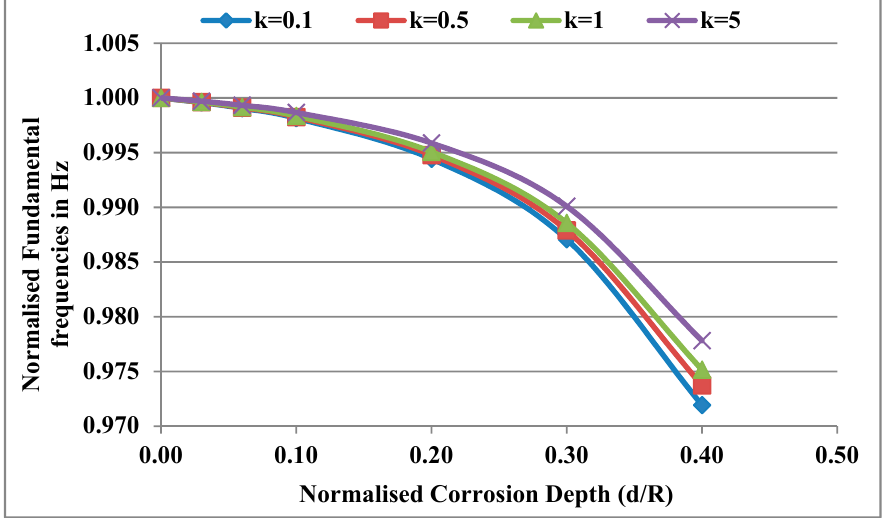
Figure 8. Effect of d/R for different power law indices (k) on the fundamental frequencies of the FG rotor system.